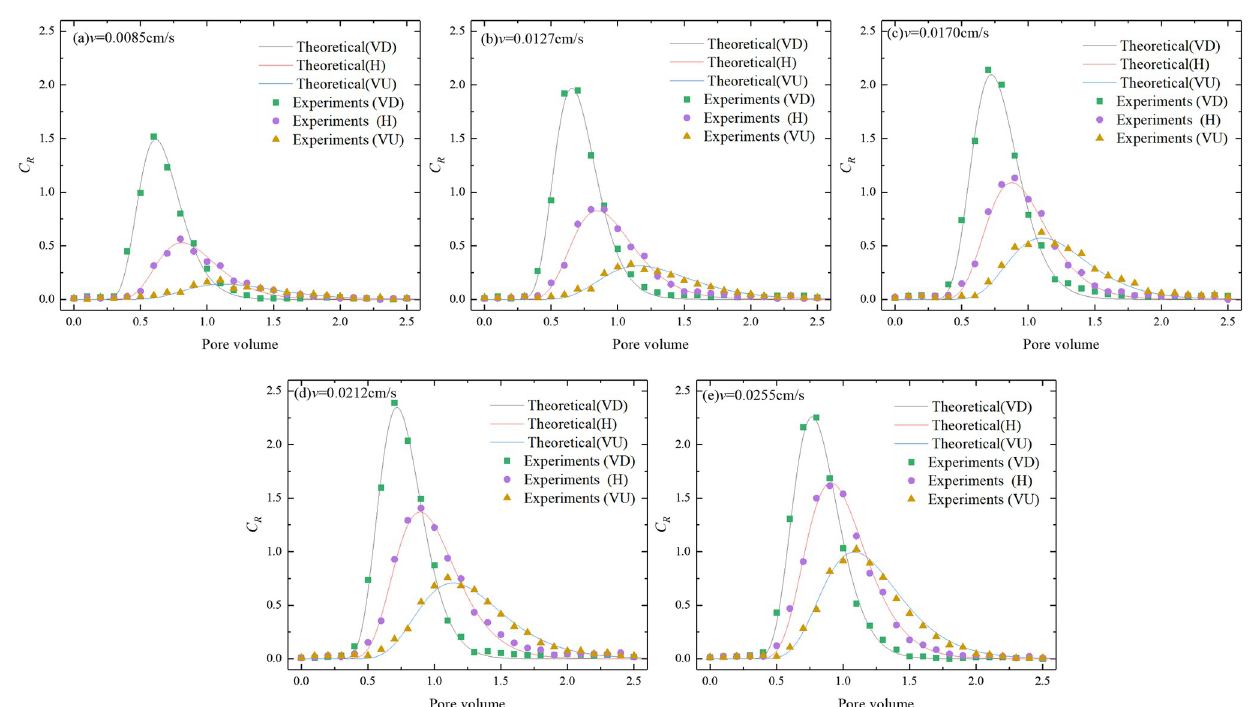
Fig 6. Particle penetration curves under the different seepage directions and different